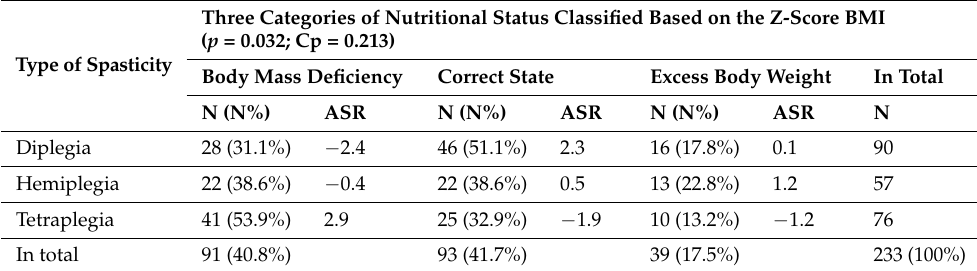
Table 14. Relationship between three categories of nutritional status and type of spasticity. Three Categories of Nutritional Status Classified Based on the Z-Score BMI ( p = 0.032; Cp = 0.213) Type of Spasticity